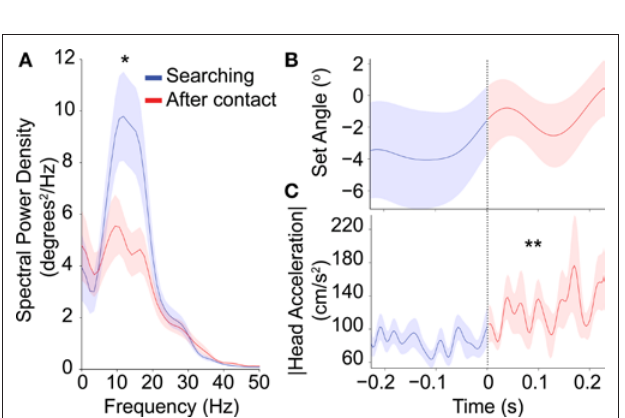
FigurE 4 | Averaged data on the transition between immobile and search phase. Averages triggered to onset of head motion, shown for 0.5s before and after trigger point ( n = 10). Shaded regions represent the mean ± 1 SE. (A) The peak in the spectral power centered at approximately 14 Hz increases upon searching onset. (B) Whisker set angle significantly increases at the onset of searching. (C) The increase in head acceleration coincides with the searching onset. Double asterisks denote significant changes (paired ranked sum test, p < 0.01).